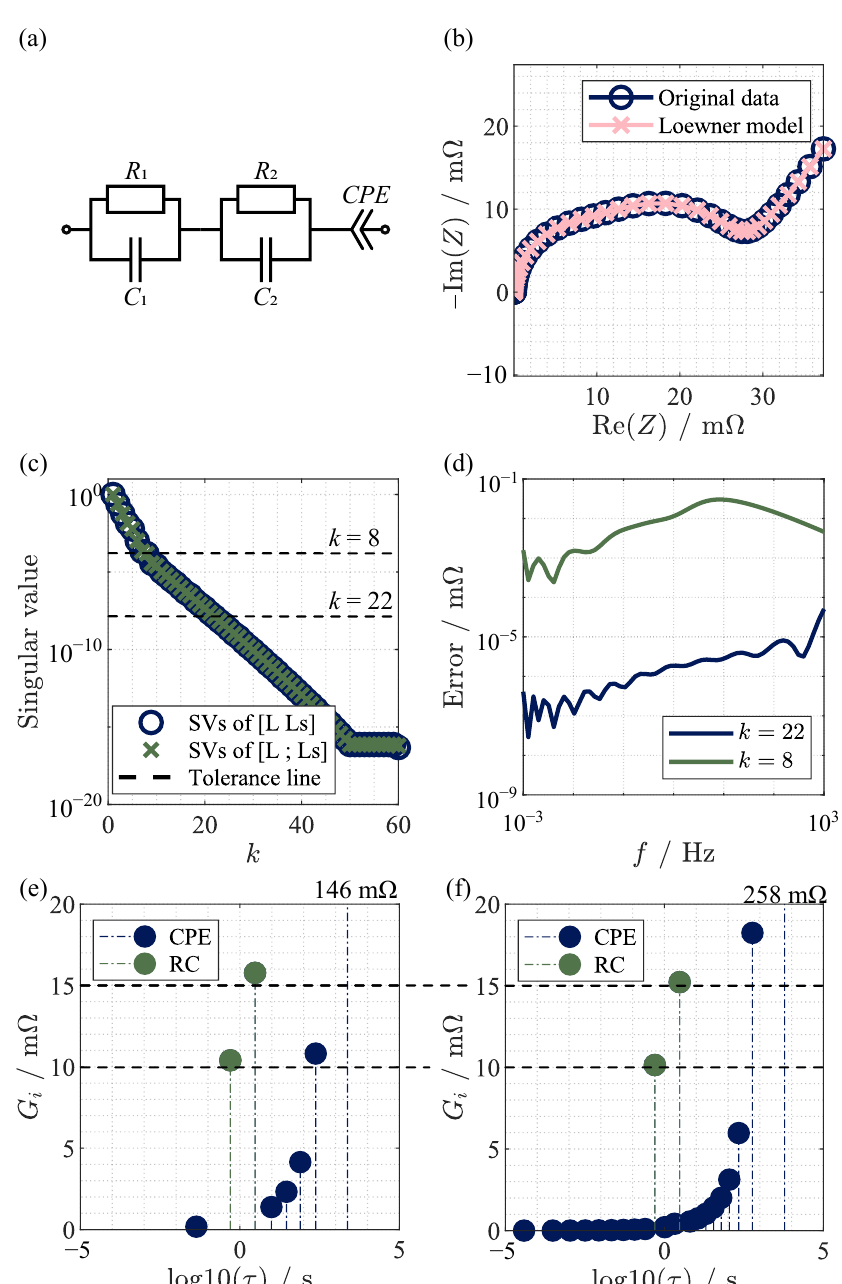
Figure 3. ECM for two RC elements and CPE ( a ), Nyquist plot of the impedance Z RC,CPE and LM with k = 22 ( b ), SVD of the Loewner matrices ( c ), error of magnitude for different model orders ( d ), DG for k = 8 ( e ) and k = 22 ( f